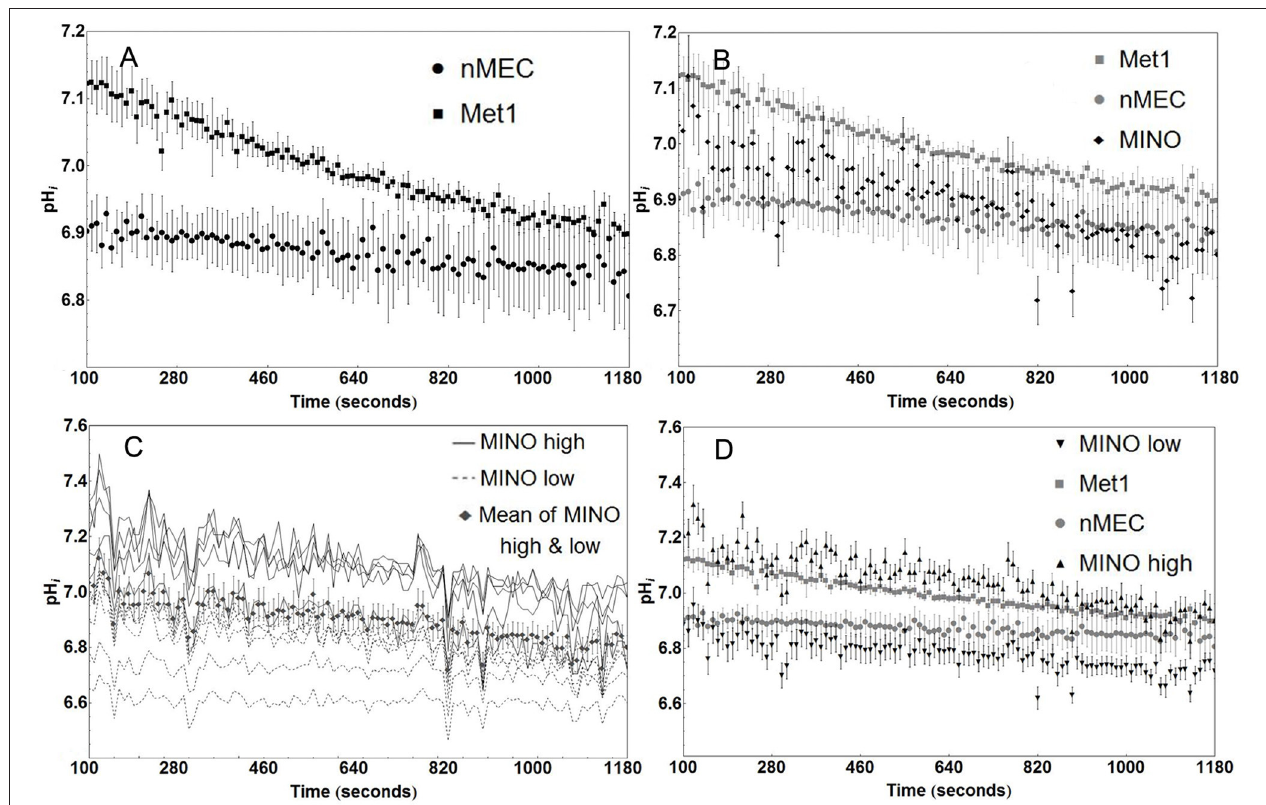
FIGURE 4 | MINO cells display metabolic heterogeneity compared with Met1 and nMEC. Cancer cells (Met1, n = 6 coverslips) have a higher rate of intracellular acidification than normal mammary epithelial cells (nMEC, n = 3 coverslips) as measured by sodium washout experiments. Mean pHi values were significantly different in more than 98% percent of the measured time points prior to but none after 430s (Welch’s t -test, P < 0.05). (A) The mean rate of acidification in MINO cells ( n = 11 cells) falls nominally between the nMEC and Met1 rates of acidification, without significant difference (B) . Baseline pHi for individual MINO cells divide into two groups that we called MINO high ( n = 6 cells) and MINO low ( n = 5 cells) (C) . MINO high cells share similar baseline pHi as Met1 cells, MINO low cells share similar baseline pHi as nMEC cells. The separation of MINO high and low data reflects the Met1 and nMEC attributes, respectively. (D) Markers on the plot represent the average and standard error for pHi at each time